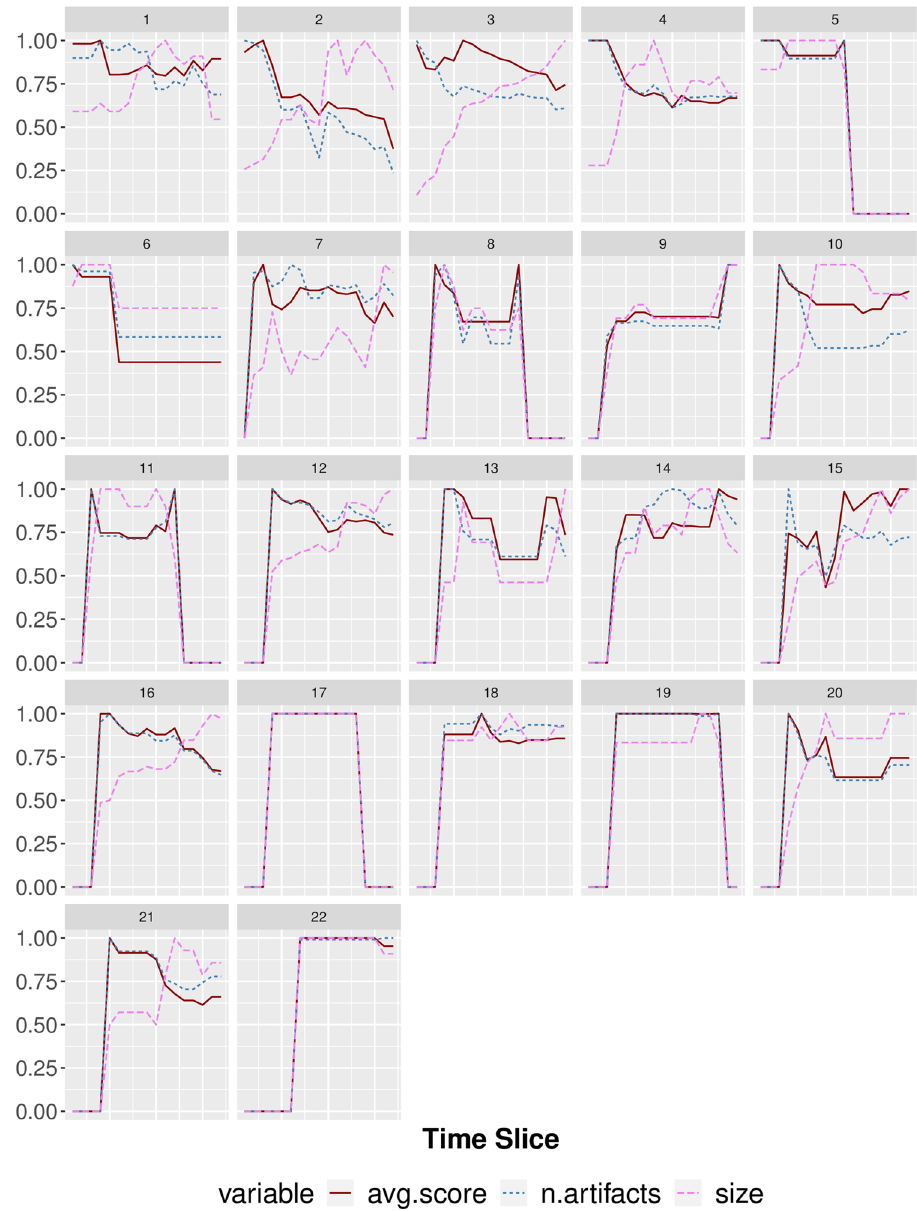
Figure 7. Each plot shows team size, number of artifacts and average IC score of a team over time. Only teams with lifespan ten or larger are considered. Time slice on the x -axes and observed variables (in percentage w.r.t maximum value) on the y -axes. Color and line type represents size, number of artifacts and average IC